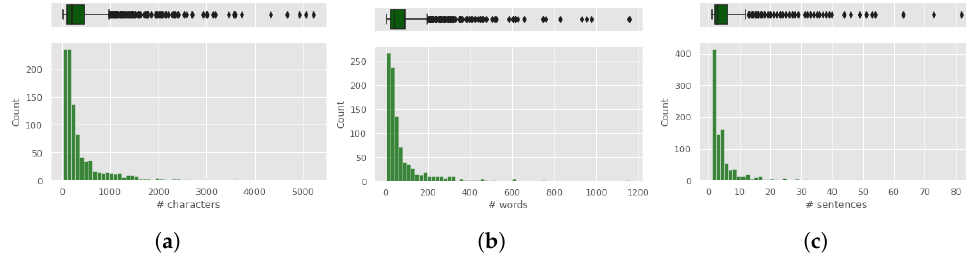
Figure 5. Quantity attributes of fake news items: ( a ) No. of characters, ( b ) No. of words and ( c ) No. of sentences.